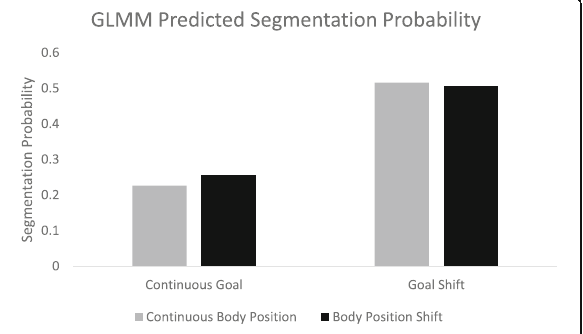
Fig. 5 Predicted segmentation likelihood from logistic mixed effects model by condition. GLMM, generalized linear mixed